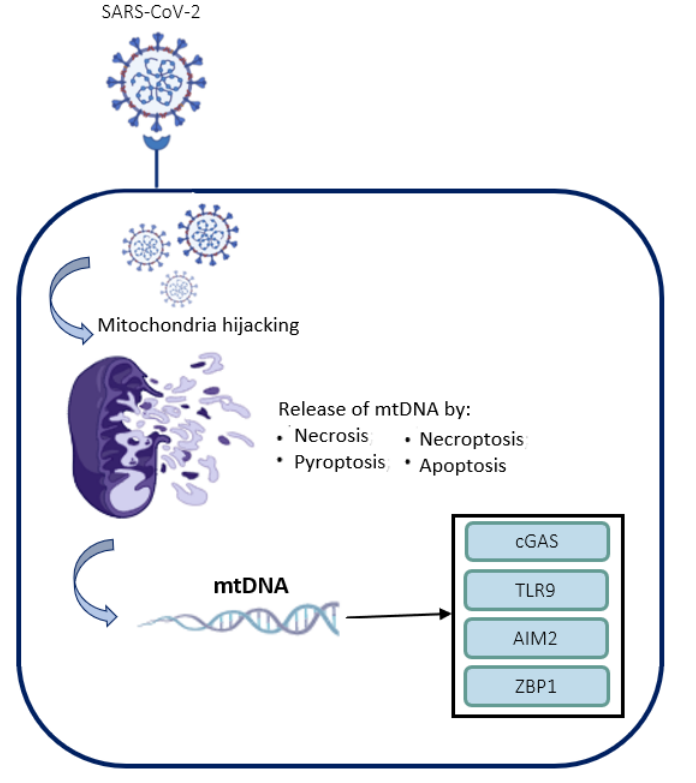
Figure 3. DNA receptors and SARS-CoV-2 mechanisms upon infection. Scheme showing the hijacking of mitochondria due SARS-CoV-2 entry. The mitochondria release mtDNA as consequence of different process, such as necrosis, pyroptosis, necroptosis and apoptosis. The mtDNA can be recognized by TLR9, cGAS, AIM,